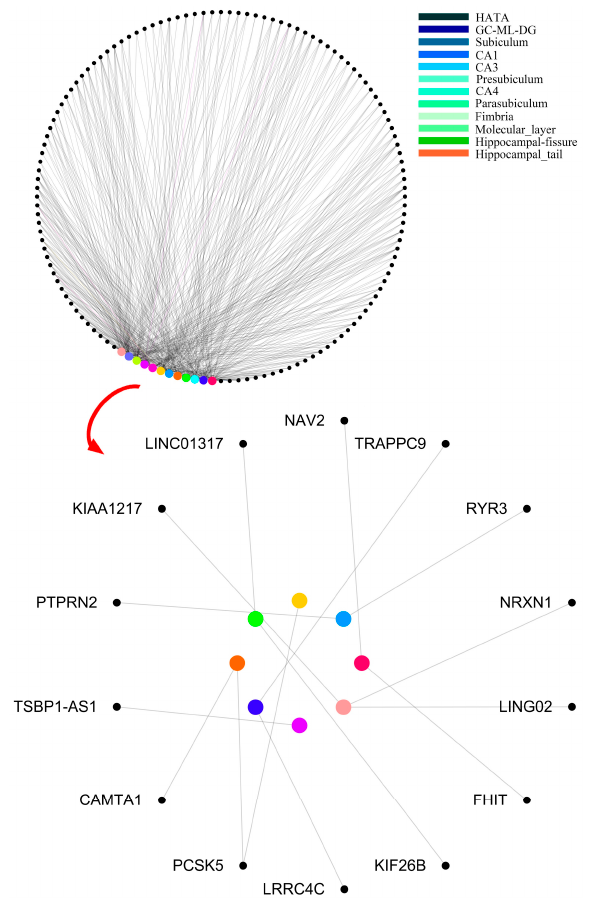
Figure 11. The top 475 “subregion-gene pairs” and the first 15 important “subregion-gene pairs”. Nodes denote the subregions and genes. Edges denote the association between subregions and genes, and the widths of edges denote the frequency of each “subregion-gene pair”.